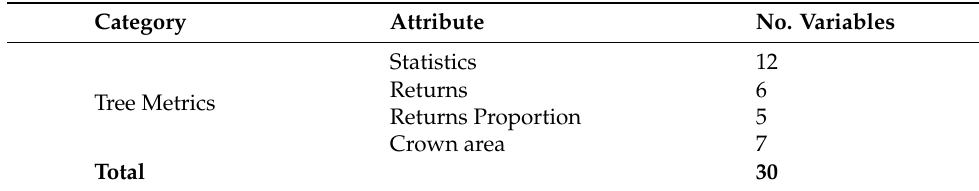
Table 3. Within the category of tree metrics, various attributes of different complexity were created based on the LiDAR return dataset, namely Returns (simple signal counts for different height sections), Statistics (mean of intensity, signal count and signal number for different height sections), Return Proportion (proportions of returns from specific tree heights of a tree’s point cloud) as well as several metrics on crown area and